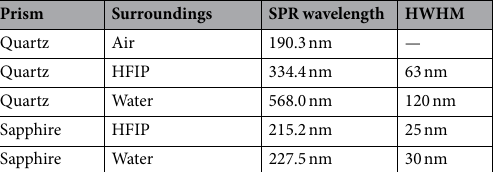
Table 1. SPR wavelength and half width at half maximum (HWHM) dependence on the surroundings of the Al thin film on quartz and sapphire prisms.